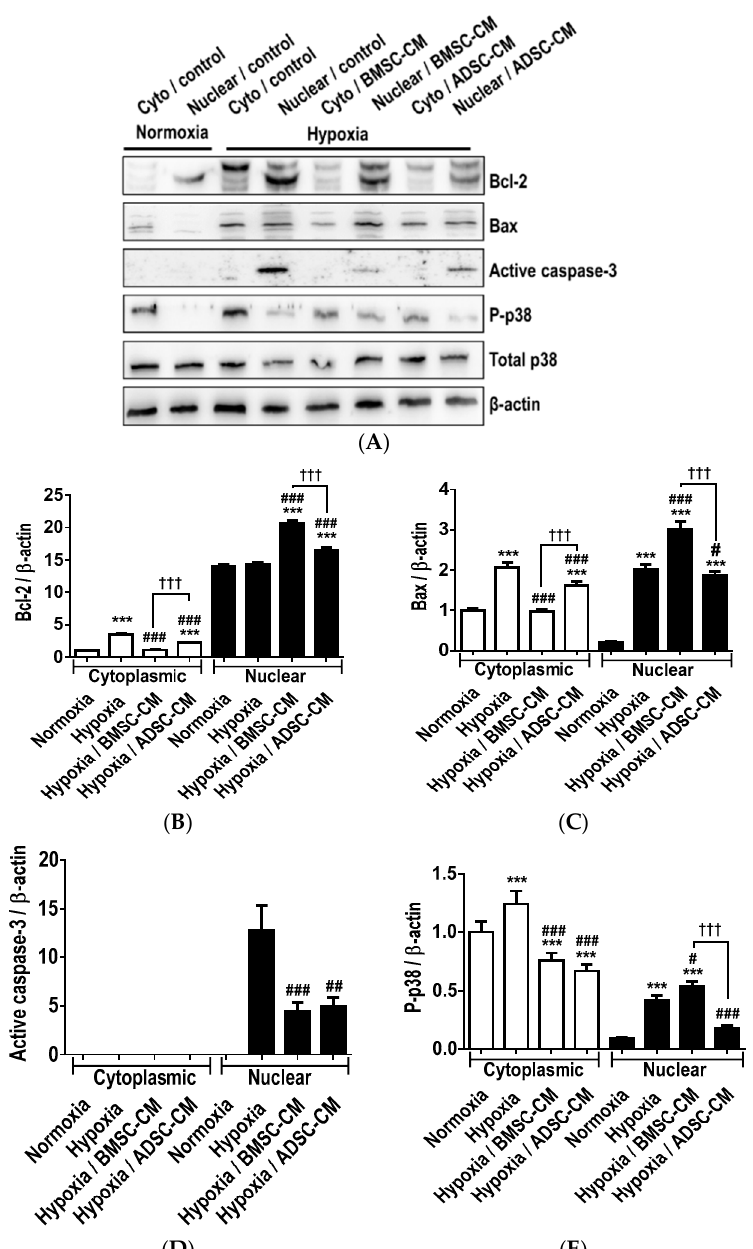
Figure 5. ( A ) Western blot analysis exploring modulatory effects of human MSC-CM on the activation of cellular stress signalling mediators in primary rat AECs exposed to hypoxia (1.5% O 2 ) for 24 h Cytoplasmic and nuclear accumulation of ( B ) Bcl-2, ( C ) Bax, ( D ) activate caspase-3 and ( E ) phosphorylated p38 were quantitated by densitometry and normalized to β -actin. Data presented as mean ± SD; n = 3 (*** p < 0.001 vs. normoxia control; # p < 0.05. ## p < 0.01, ### p < 0.001 vs. hypoxia control and ††† p < 0.001 vs. hypoxia/BMSC-CM ) . The resulting data were statistically analysed using one-way ANOVA and Tukey’s multiple comparison test.